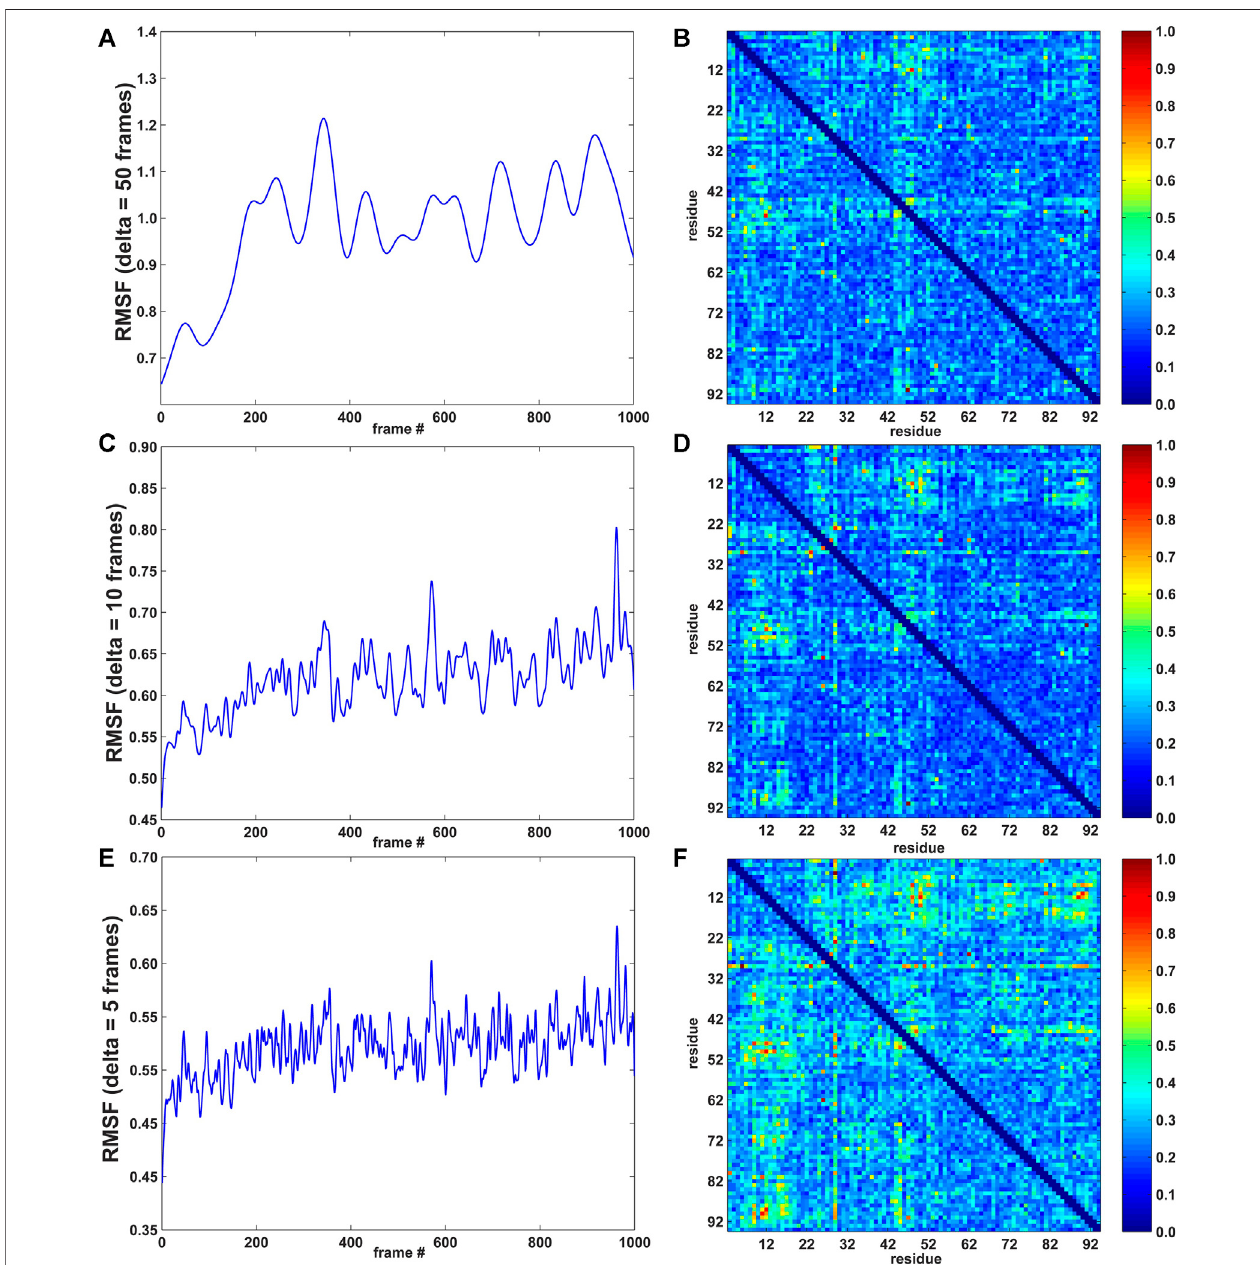
FIGURE2| RMSFcurves(left;arbitraryunits)andpairwiseresidueMImatrices(right;normalizedtoarangeof[0,1])forthreevaluesof δ (windowwidth:50,10,and 5 frames; 1frame (cid:1) 0.5 ps forthe 10 m/sSMD velocity;see Methods section). (A) RMSF for δ (cid:1) 50 frames. (B) MIpairwise matrix for δ (cid:1) 50frames. (C) RMSF for δ (cid:1) 10 frames. (D) MI pairwise matrix for δ (cid:1) 10 frames. (E) RMSF for δ (cid:1) 5 frames. (F) MI pairwise matrix for δ (cid:1) 5